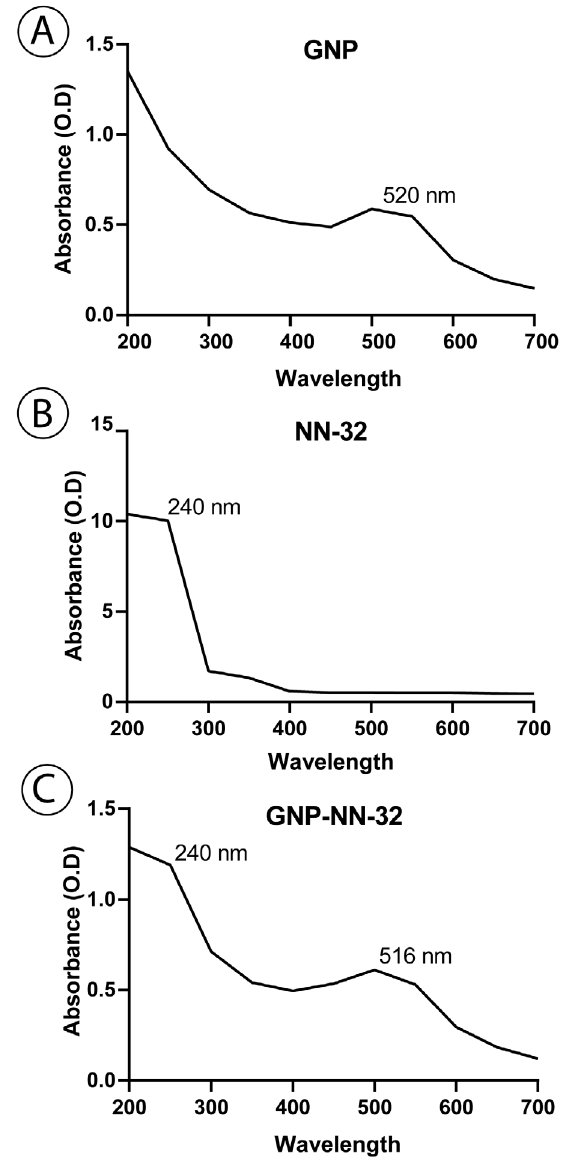
Figure 1. Characterization of GNP-NN-32 by UV-VIS Spectroscopy. (A) Absorbance spectra of GNP (λ max = 520 nm). (B) Absorbance spectra of NN-32 (λ max = 240 nm). (C) Absorbance spectra of GNP-NN-32 (λ max = 516